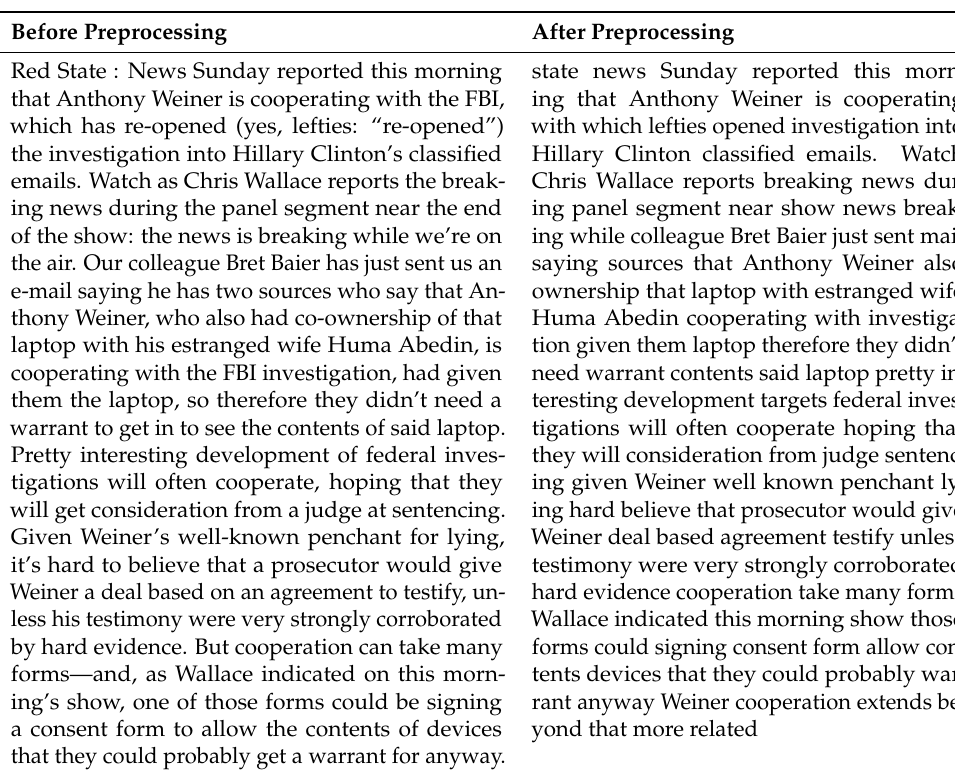
Table 4. Transition steps in data